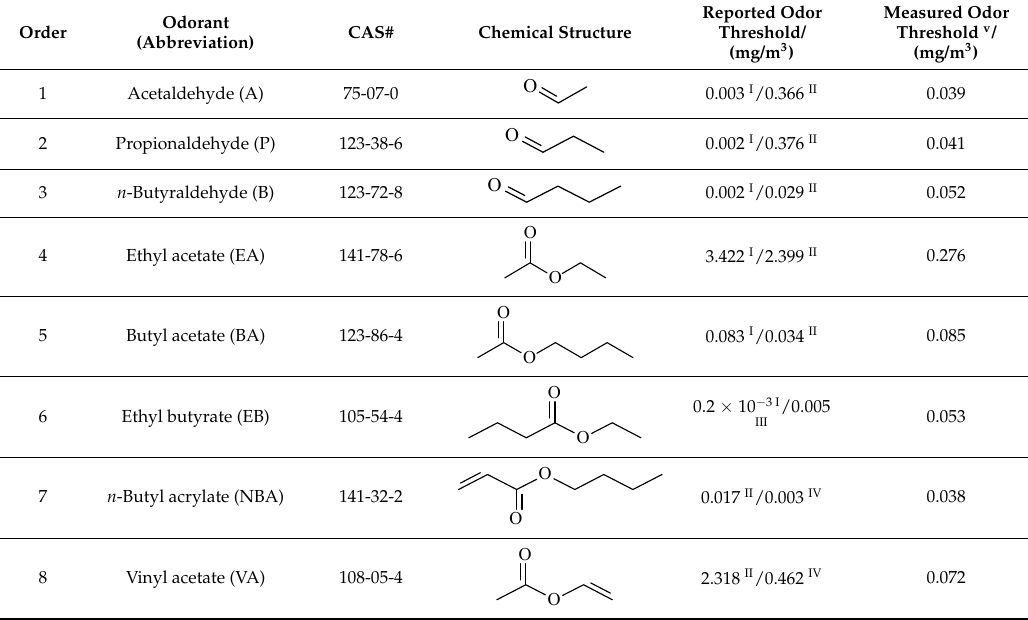
Table 1. List of odorants used for odor sample preparation.